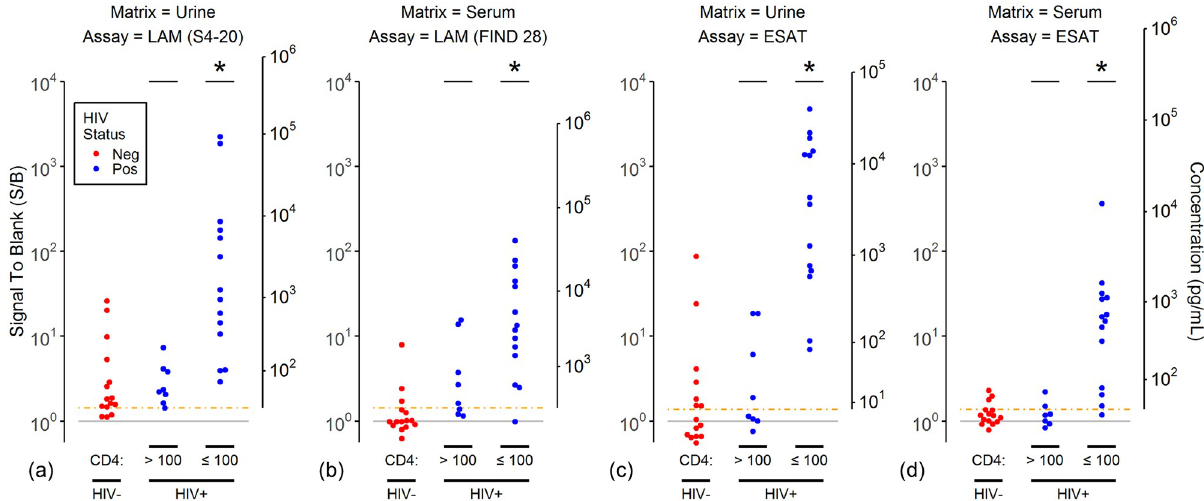
Fig 5. Association of LAM and ESAT-6 concentrations with HIV status and CD4 counts. The plots show the assay signals (left axis) and estimated concentrations (right axis) for (a) LAM measured in urine using the S4-20 capture antibody, (b) LAM measured in serum using the FIND 28 capture antibody, (c-d) ESAT-6 measured in urine and serum. The plots are formatted as described for Fig 2, except only the TB+ subjects are shown, points are colored by HIV status, and the TB+/HIV+ subjects are separated into two groups based on CD4 cell count ( > 100 cells/uL and � 100 cells/uL). An “ � ” above the data points for a TB+HIV+ group indicates the distribution is significantly different than the distribution of points for the TB+HIV- subjects in the same plot (Mann-Whitney test, p < 0.05).